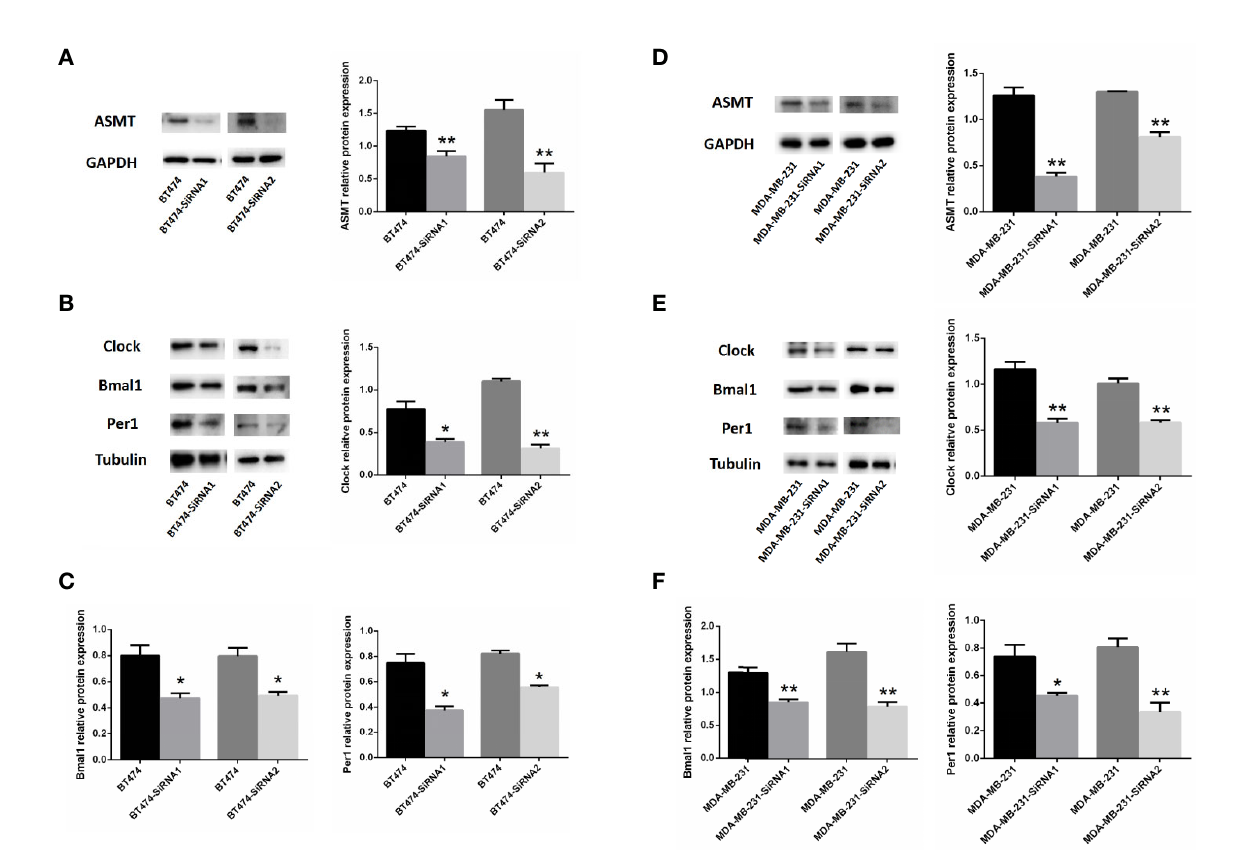
FIGURE 4 | Inhibition of ASMT reduces the circadian clock system levels in BT-474 and MDA-MB-231 cells. (A) ASMT expression measured by Western blotting following siRNA treatment and quanti fi cation of ASMT levels relative to GAPDH in BT-474 cell. (B, C) The expression and quanti fi cation of CLOCK, BMAL1, and PER1 protein relative to tubulin measured by Western blotting in BT-474 cell. Data are the mean ± SEM (n = 3). * p < 0.05, ** p < 0.01. (D) ASMT expression measured by Western blotting following siRNA treatment and quanti fi cation of ASMT levels relative to GAPDH in MDA-MB-231 cell. (E, F) CLOCK, BMAL1 and PER1 expression and quanti fi cation relative to tubulin measured by Western blotting in MDA-MB-231 cell. Data are the mean ± SEM (n = 3). * p < 0.05, ** p <